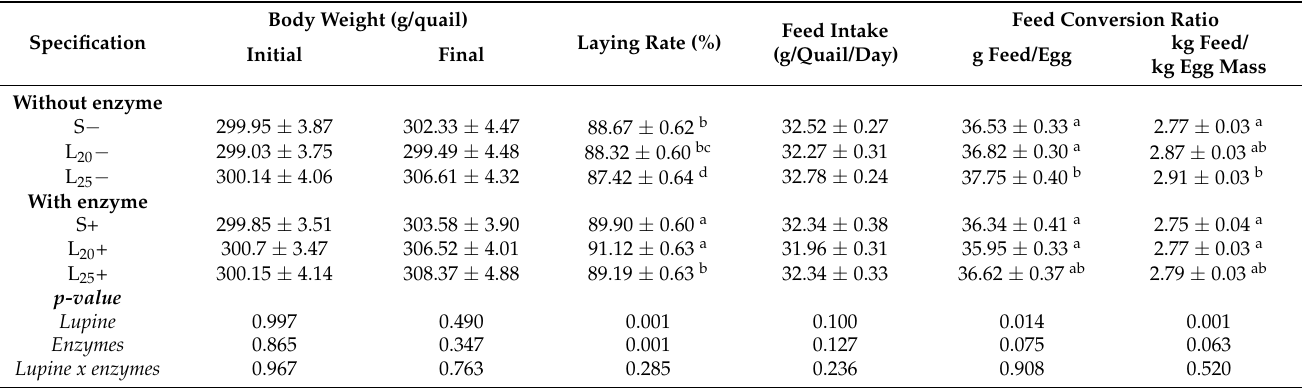
Table 3. Influence of enzymes addition in lupine-based diets on the productive performance of quails (mean ± std.